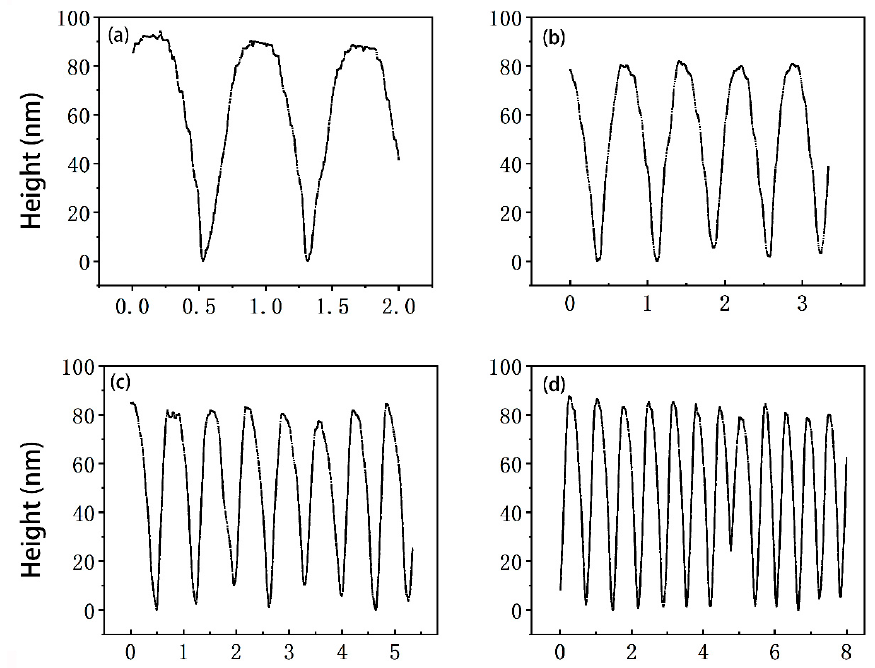
Figure 12. Profiles of the scanned images in Figure 11 (marked in Figure 11): ( a ) Scan range 2 μ m × 2 μ m; ( b ) scan range 3.3 μ m × 3.3 μ m; ( c ) scan range 5.3 μ m × 5.3 μ m; ( d ) scan range 8 μ m × 8 μ m.